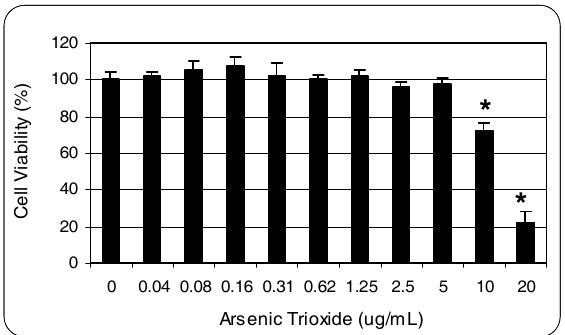
Figure 1: Toxicity of arsenic trioxide to human leukemia (HL-60) cells. HL-60 cells were cultured with different doses of arsenic trioxide for 6 hours as indicated in the Materials and Methods. Cell viability was determined based on the MTT assay. Each point represents a mean value and standard deviation of 3 experiments with 6 replicates per dose. Cell Viability in 10 and 20 µg/mL are significantly different ( p < 0.05) compared to the control according to ANOVA Dunnett’s